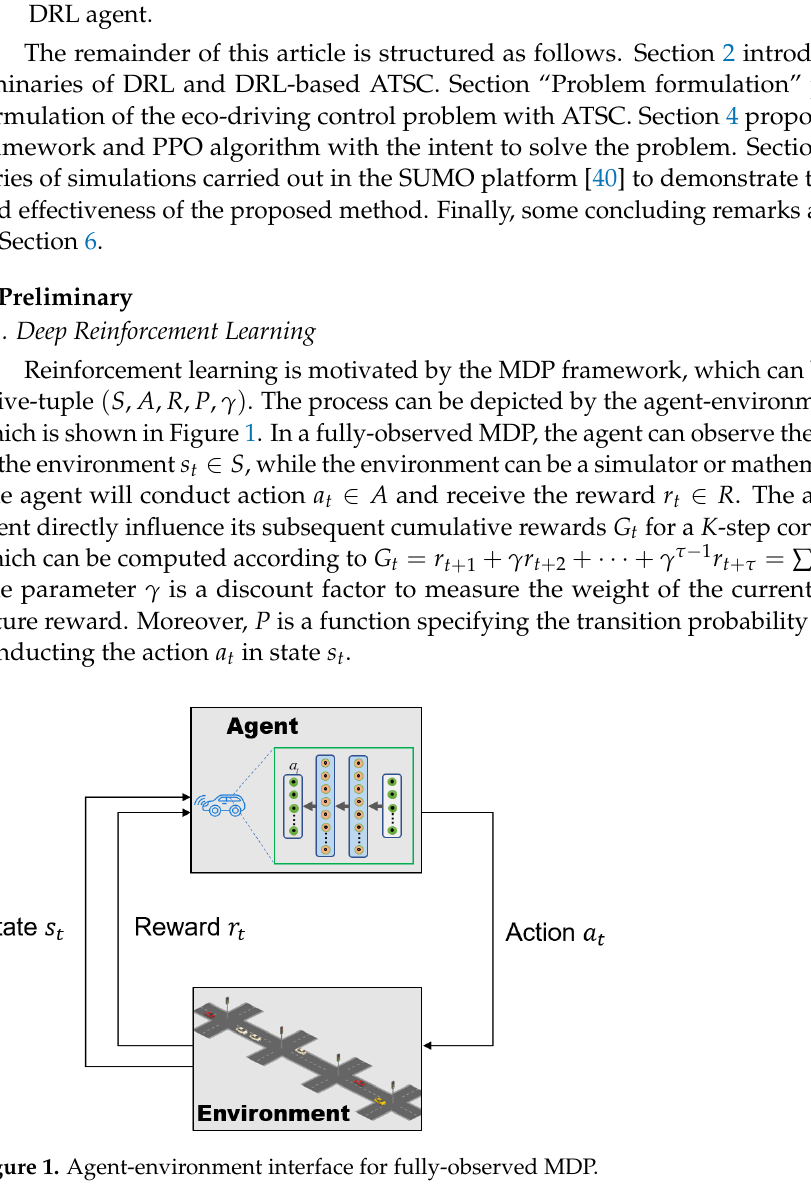
Figure 1. Agent-environment interface for fully-observed MDP.